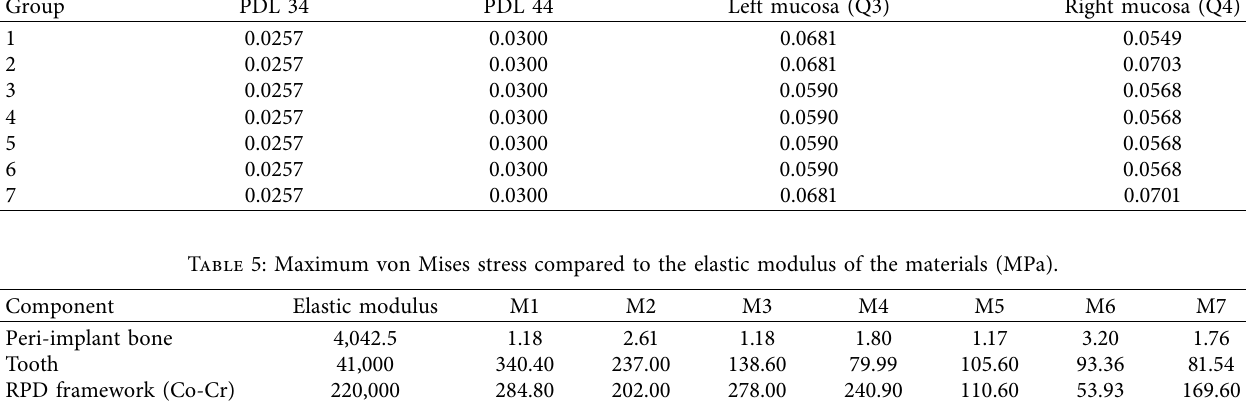
Table 4: Average hydrostatic pressure of the periodontium and mucosal tissue on the edentulous areas (MPa). Group